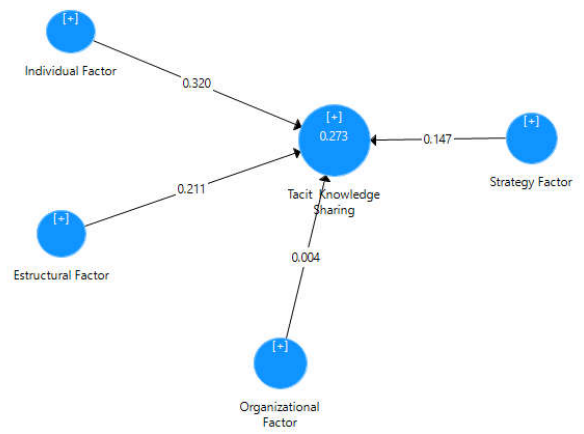
Figure 2. Path coefficient values. Source: SmartPLS.